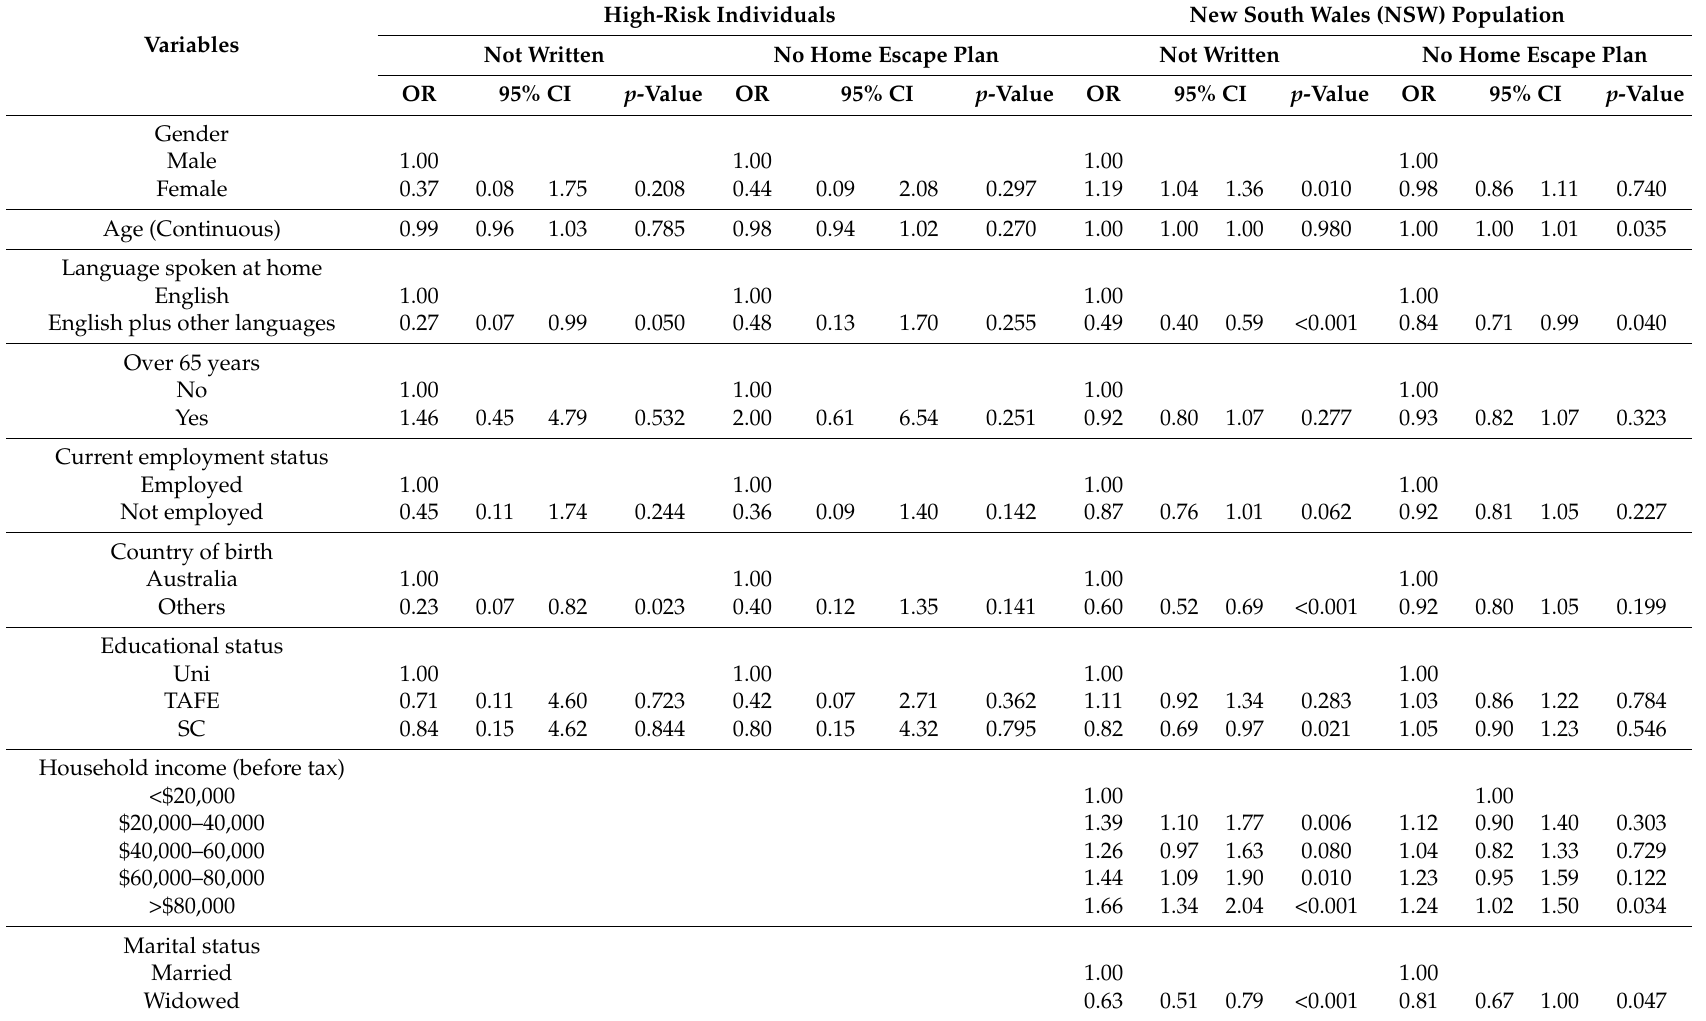
Table 3. Home fire escape plan. Univariate